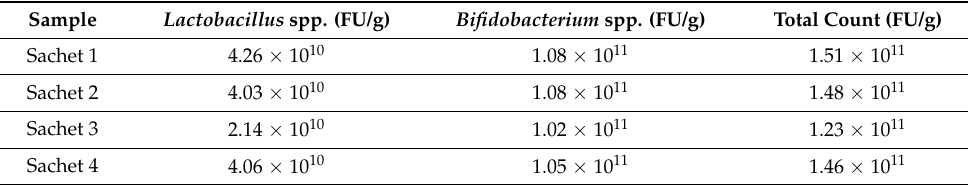
Table 6. Probiotic counts of food supplement 2 obtained by flow